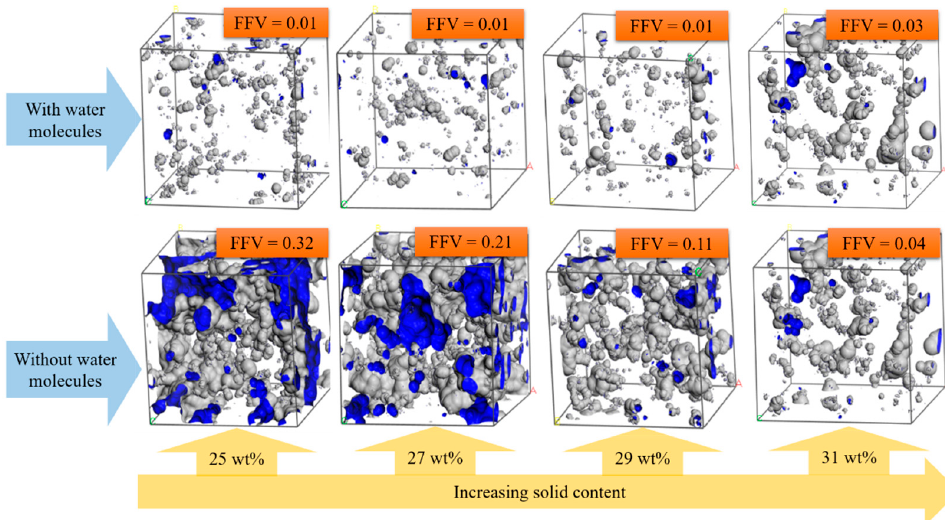
Figure 11. Free-volume snapshot of aluminum sols with different amounts of solid content at 298 K.